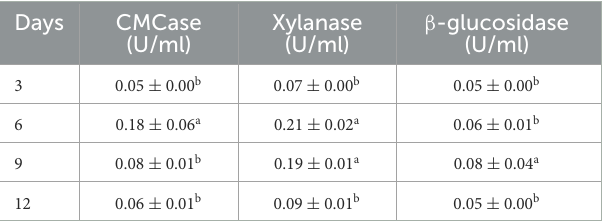
TABLE 3 Carboxymethyl cellulase (CMCase), xylanase, and β -glucosidase activities of A. niger during the AVL fermentation process at 3, 6, 9, and 12 days.